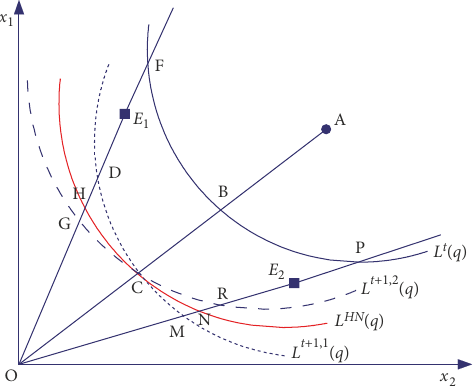
Figure 1. Input biased technological change and input requirement